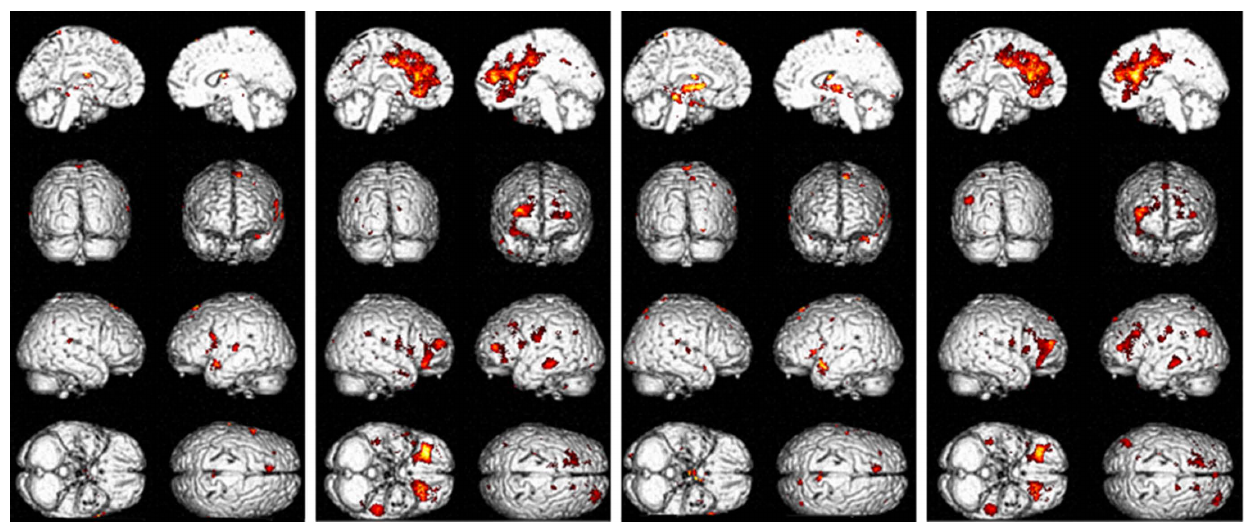
to working memory processing (Barch et al., 1997). Additionally the pars opercularis of the inferior frontal gyrus is active when people suppress motor responses (Aron et al., 2007), and stimula- tion causes changes in motor cortical activity (Buch et al., 2010).